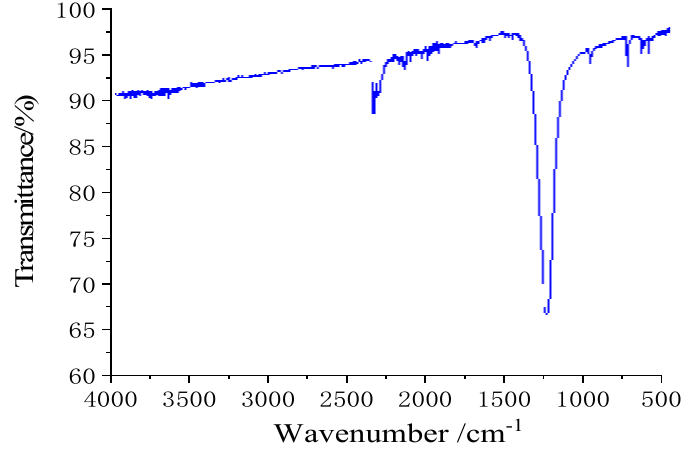
Figure 7. FT − IR pattern of sample.